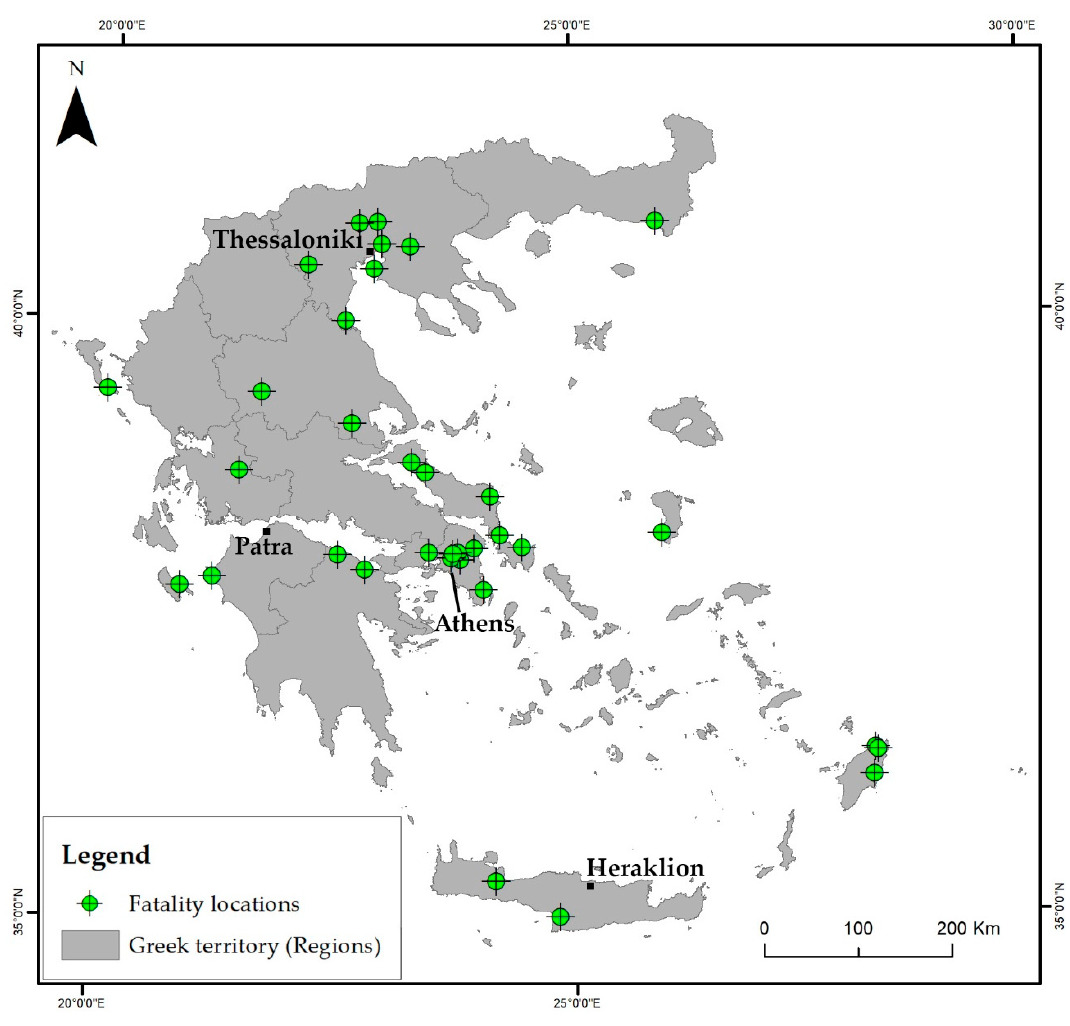
Figure 3. Map of the locations of the studied fatal incidents across Greece.